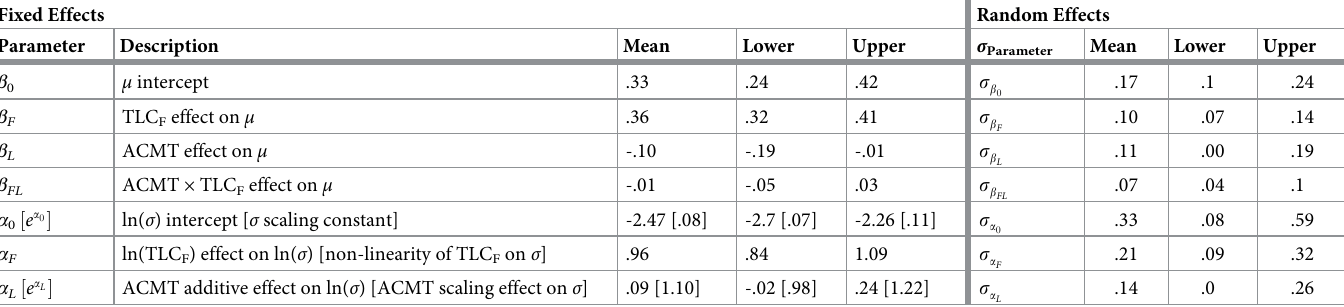
Table 1. Posterior means and 95% HDIs for parameters predicting the mean and spread of TLC T , and their estimated variation across the